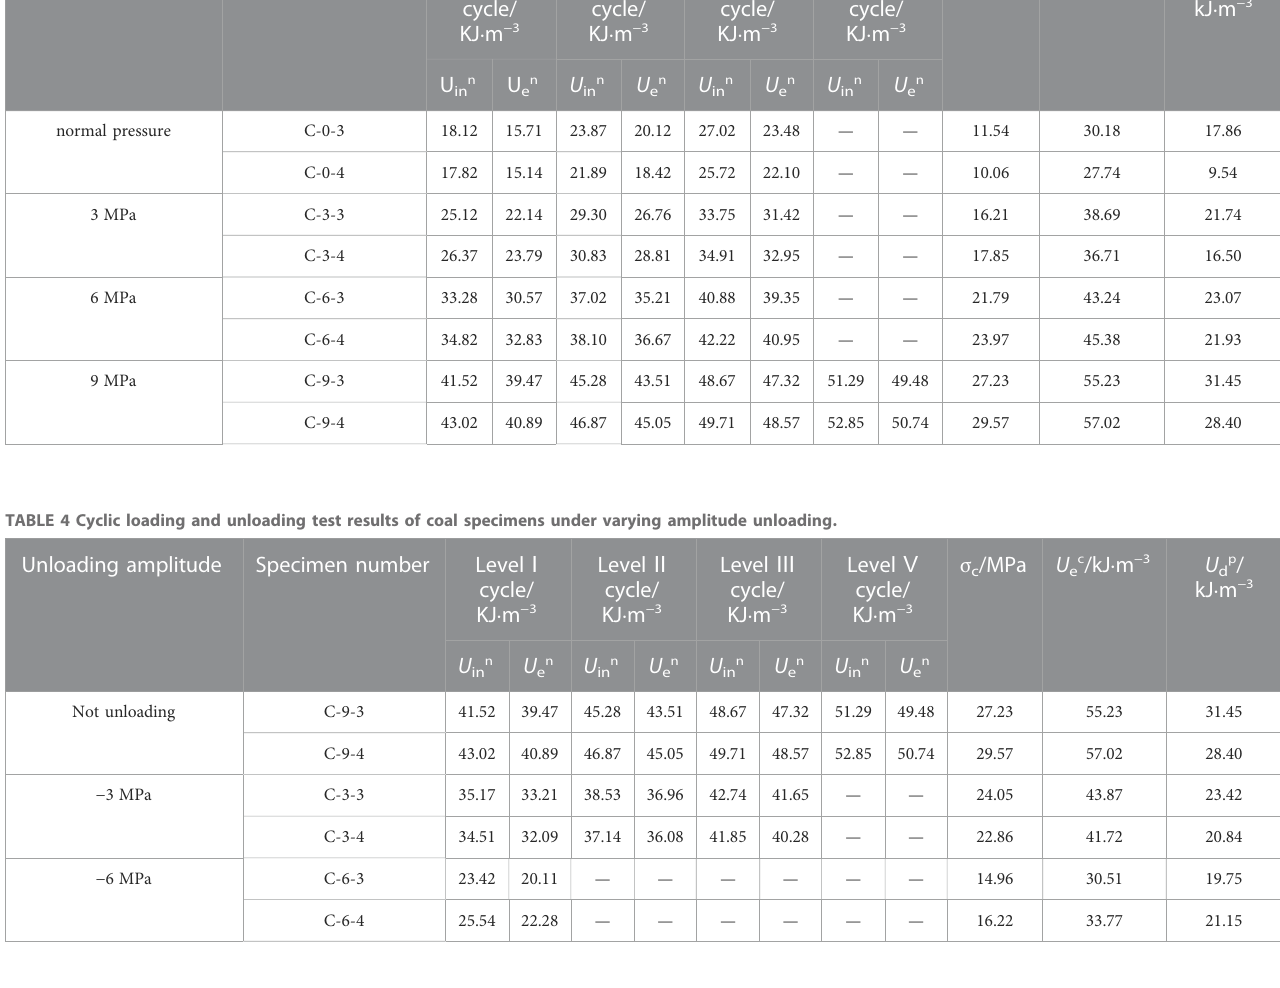
TABLE 3 Cyclic loading and unloading test results of coal specimens under varying con fi ning pressures. Con fi ning pressure